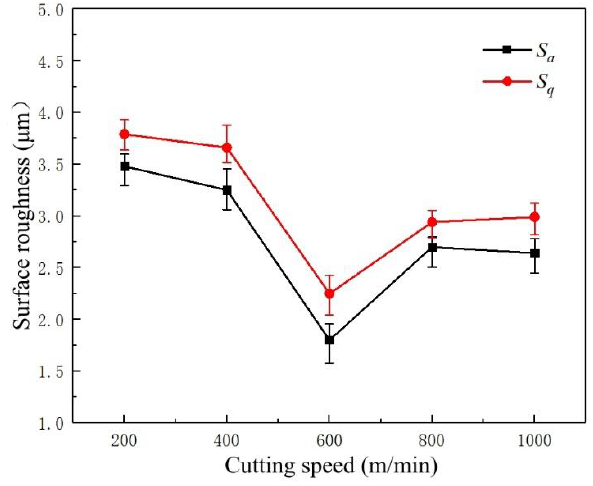
Figure 6. The variation trend of cutting speed on the surface roughness of the machined surfaces.